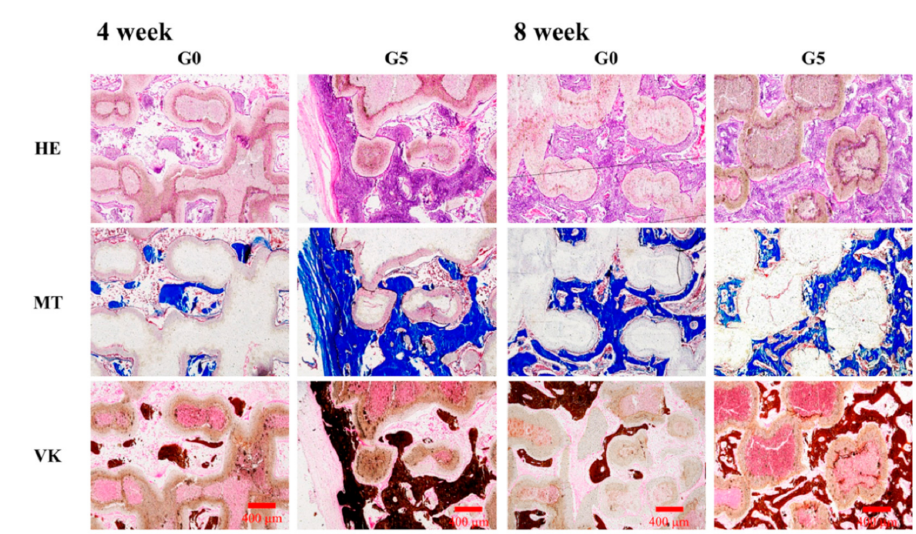
Figure 10. Hematoxylin-eosin (HE), Masson’s trichrome (MT) and von Kossa (VK) staining evaluating new bone regeneration quality of G0 and G5 scaffolds in a critical-sized bone defect in vivo at 4 and 8 weeks of implantation. The scale bar is 400 µ